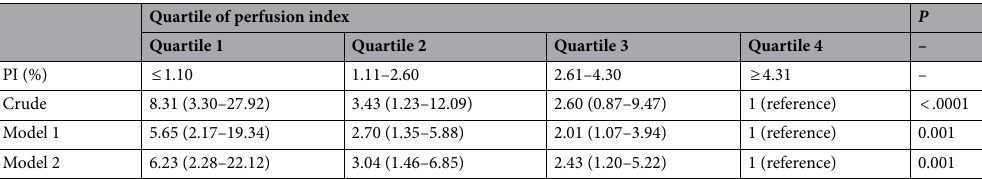
Table 3. Unadjusted hazard ratios and multivariate adjusted hazard ratios for cardiovascular death. PI, perfusion index. Model 1 is adjusted for sex, age, body mass index, heart rate, creatinine and smoking status. Model 2 includes all variables in Model 1 plus duration of diabetes, systolic blood pressure, hemoglobin A1c, total cholesterol, anti-platelet therapies, renin-angiotensin system inhibitor, glucagon-like peptide-1 agonists, sodium-glucose cotransporter 2 inhibitor and statin.